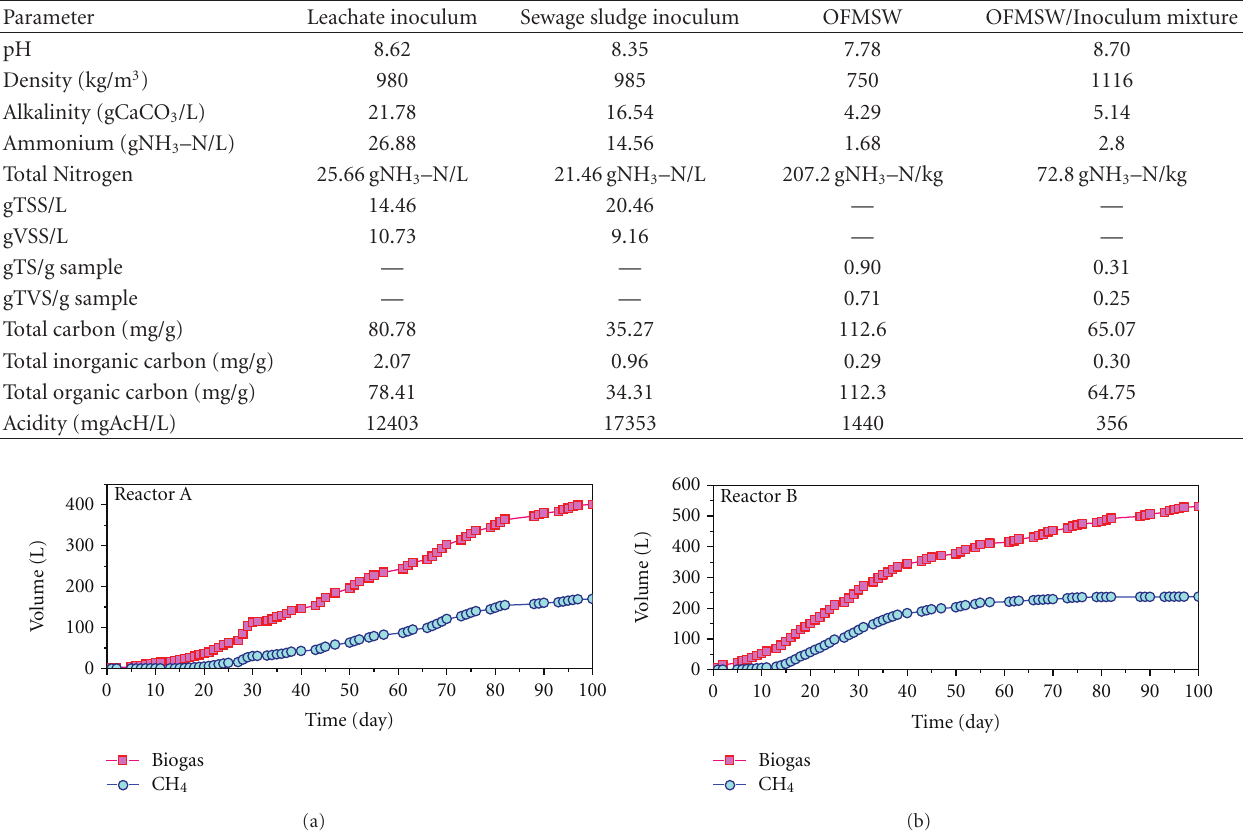
Table 2: Composition of the wastes used to start-up the CSTR.